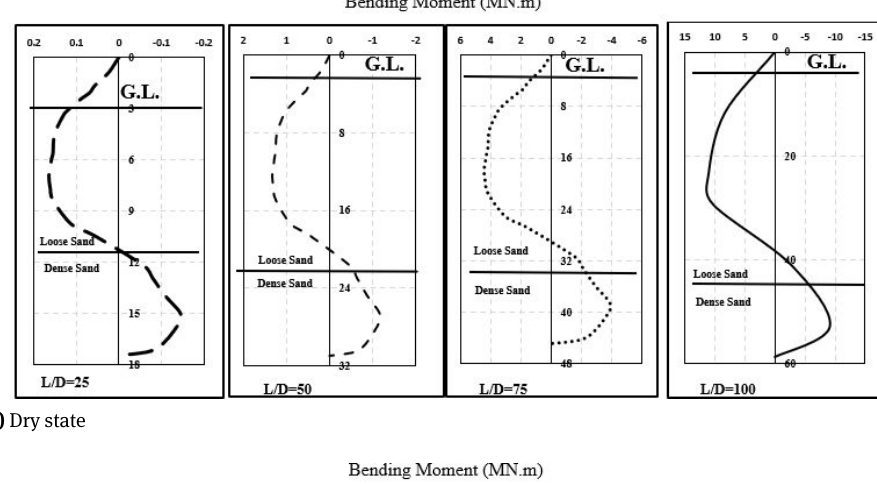
settlements developed from the ground shaking. Once the excess pore water pressure reaches the initial vertical ef- fective stress of the selected soil, the shear strength of the soil decreases and then. Figure 6 depicts the propagation of the excess pore water pressure ratio over time with dif- ferent slenderness ratios (L/D = 25, 50, 75, and 100). The liquefaction ratio reached the peak value at a zone below the soil surface and closed to the pile shaft (about 100%)